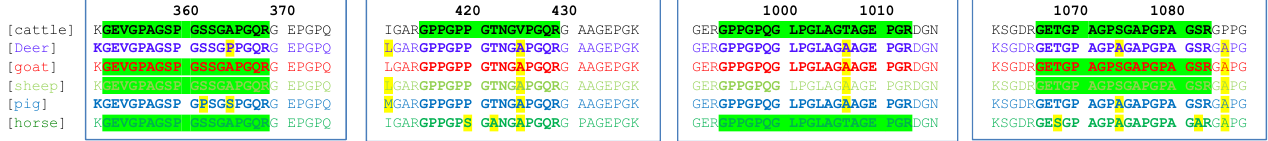
Figure 8. Part of the amino acid sequence of type III collagen. The sequences are aligned according to the residue number of bovine α1(I) chain (P02453 CO1A1_Bovin). Amino acid sequences of peptides identified by our analysis of BMM201with ESI − MS/MS are printed in bold face and highlighted in green. Amino acid residues that differ from those in cattle sequence are highlighted in yellow. Color representing the sequence of each animal species: black (cattle); purple (deer); red (goats); pale green (sheep); blue (pig); green (horse).